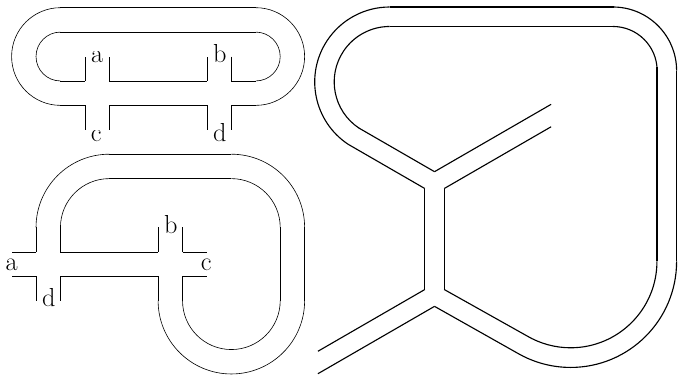
Figure 6 . Candidate planar divergences in the square lattice models (left) and single trace diver- gence arising in the hexagonal lattice model